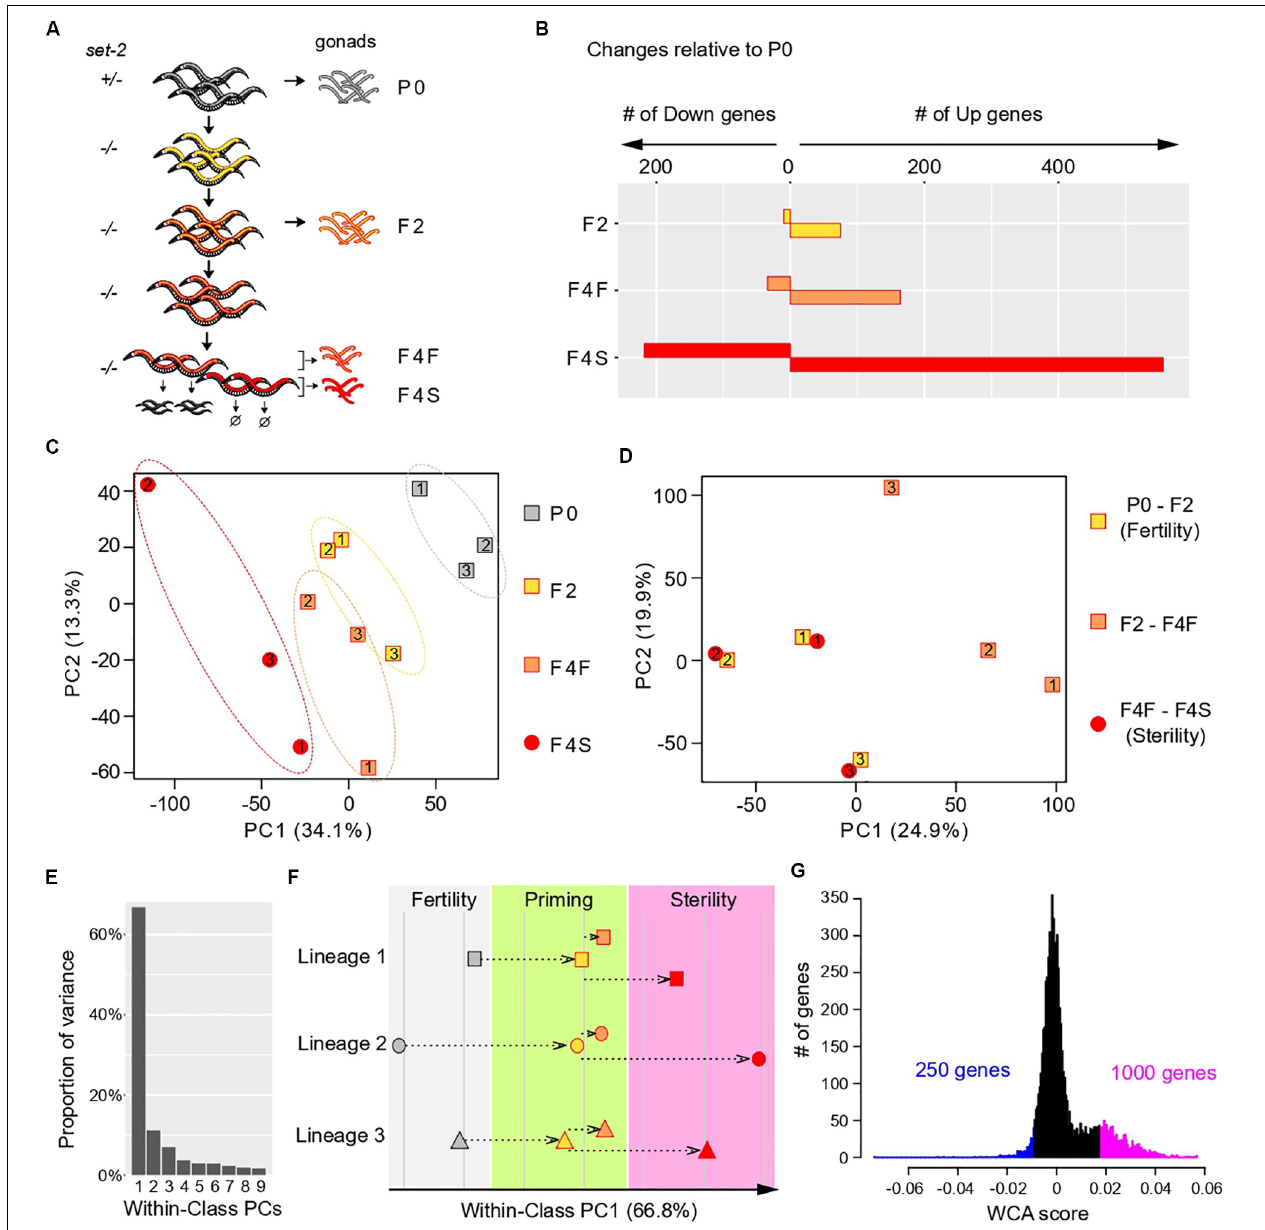
FIGURE 1 | Multivariate analysis of transgenerational transcriptional changes in set-2 mutant germlines as they progress to sterility. (A) Experimental design of the strategy used to determine transcriptional changes that take place in the gonads of set-2 mutant animals as they progressively lose their germline identity. Gonads were dissected from P0 set-2( +)/ set-2(–) hermaphrodites, from set-2(–) / set-2(–) hermaphrodites, and from fertile and sterile F4 set-2(–) / set-2(–) hermaphrodites for RNA-seq analysis. (B) Number of genes showing differential expression as compared to P0 at a conservative statistical threshold (adjusted p < 10e-6). (C) Principal Component Analysis (PCA) on expression levels. Circles and squares correspond to samples and are numbered according to their lineage. (D) PCA performed on expression differences between samples of the same lineage. Circles and squares correspond to the indicated pairwise differences, numbers indicate lineages. (E–G) Results of Within-Class Analysis (WCA) obtained by considering each lineage as a class. (E) Proportion of within-class variance explained by each component. (F) Coordinates of samples on the first component (one symbol per lineage, same color scheme as in C ). (G) Histogram showing the distribution of gene coefficients on the first components. Genes having extreme coefficients (colored in blue and magenta) are the major contributors to the orientation of the first component. These coefficients are referred to as “WCA scores” in the main text.